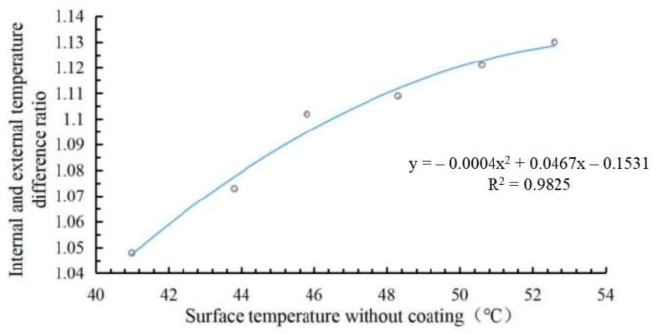
Figure 19. Trend chart of indoor and outdoor cooling value ratio.